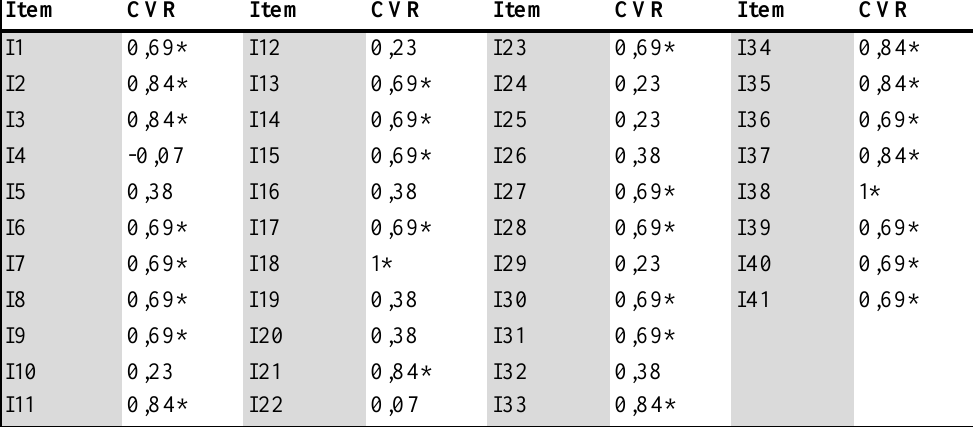
Individual and average scores of MOOCs on